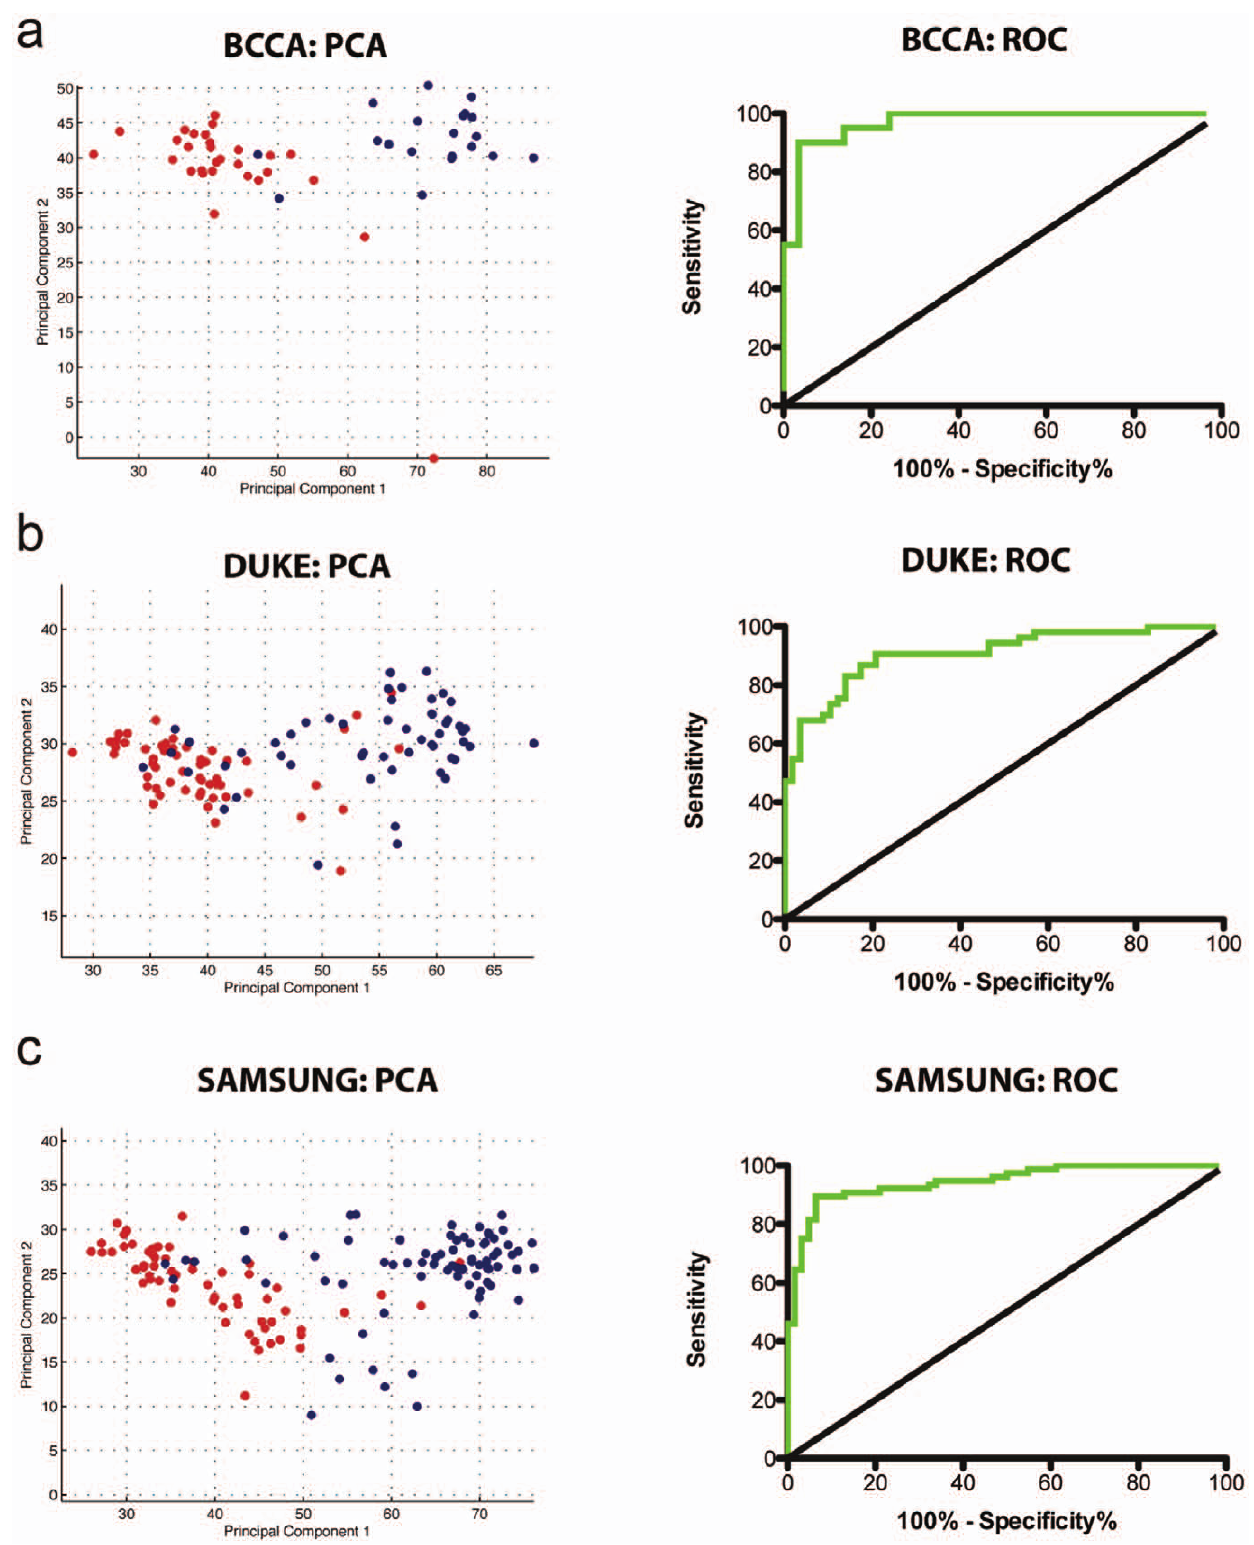
Figure 6. Subtype specific genes explain AC and SqCC phenotypes. Principal components analysis was performed utilizing all genes demonstrating expression differences between the subtypes as a result of genetic and/or epigenetic alterations using: A) Data generated for 49 NSCLC tumors (29 AC, 20 SqCC) as part of this study which was used in gene discovery; B) Publically available data from 111 NSCLC tumors (58 AC and 53 SqCC, Dataset # 3-Duke, Table S1) used as test set # 1; C) Publically available data from 138 NSCLC tumors (62 AC and 76 SqCC, Dataset # 6- Samsung, Table S1) used as test set # 2. Red circles indicate AC samples, while the blue circles indicate SqCC samples. Strong separation of the AC